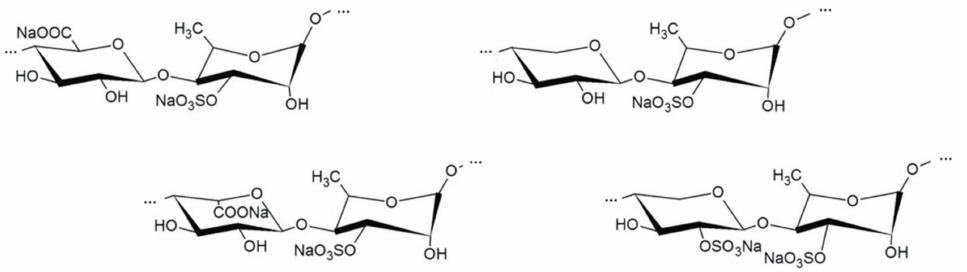
Figure 4. Structure of the main repeating disaccharides units in ulvan: ulvanobiuronic acids and